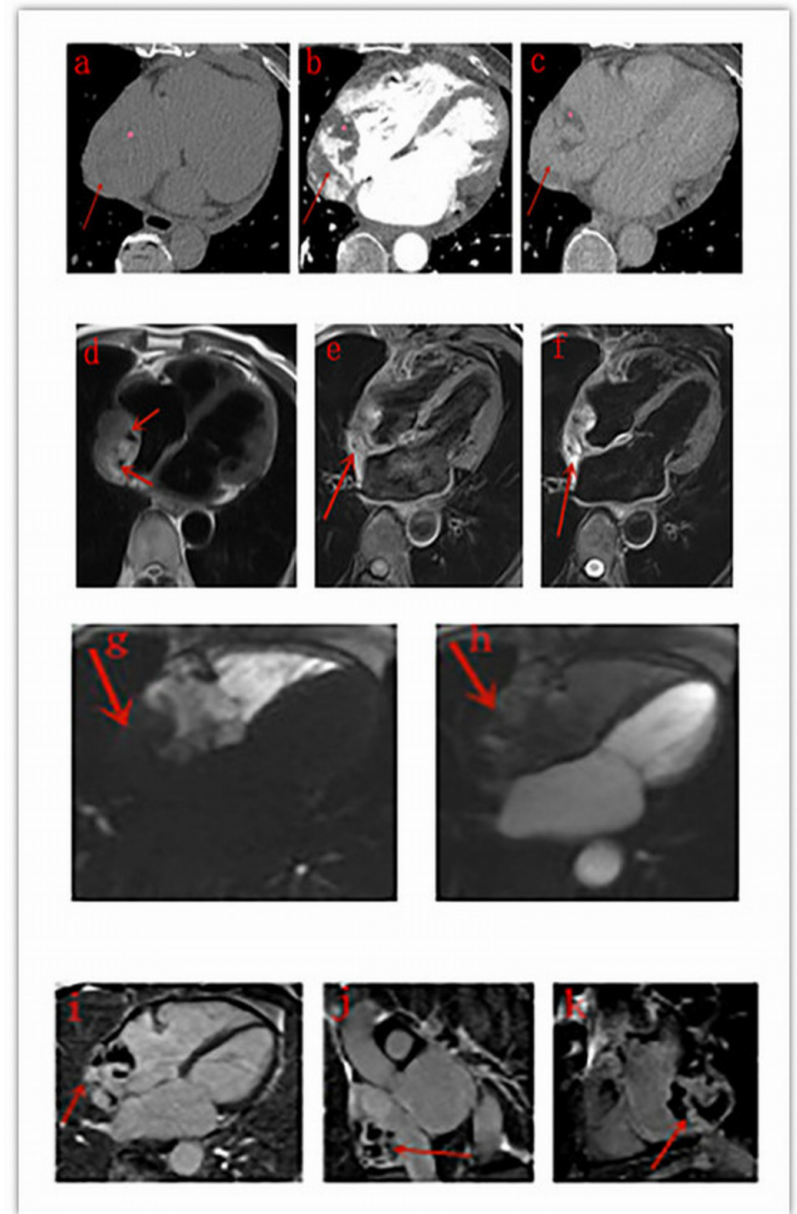
Figure 3. Male, 74 years old, right atrium angiosarcoma. ( a – c ): The mass (red arrow) in the right atrium presents as inhomogeneous density with low-density areas on plain CT scans ( a ) and shows strong heterogeneous centripetal enhancement on enhanced CT scans ( b , c ), and the low density area (pink star) shows no enhancement. ( d – f ): Signal void (red arrow) is noticed on a black-blood haste sequence ( d ). The mass (red arrow) presents as heterogeneous hyperintensity on T1WI ( e ) and T2WI ( f ). ( g – h ): On first-pass perfusion sequences, the mass (red arrow) presents as a filling defect in the right atrium as the contrast medium transits the right side ( g ) and is enhanced as the medium goes through the left side ( h ). ( i – k ): LGE shows heterogeneous patchy enhancement (red arrow) on di ff erent